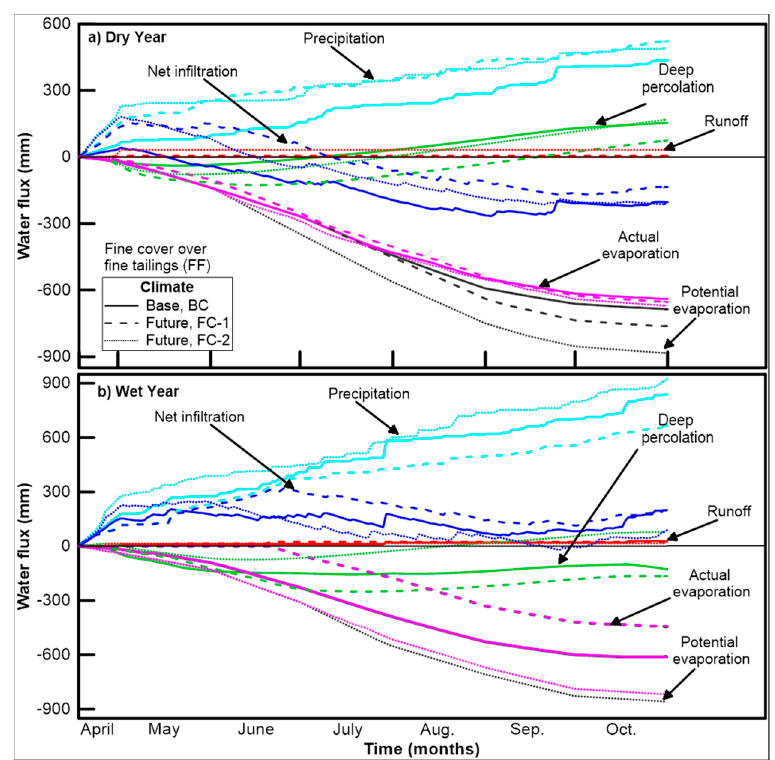
Figure 8. Water balance at the ground surface and at the tailings–cover interface for homogeneous fine profile, FF for ( a ) dry year; ( b ) wet year.